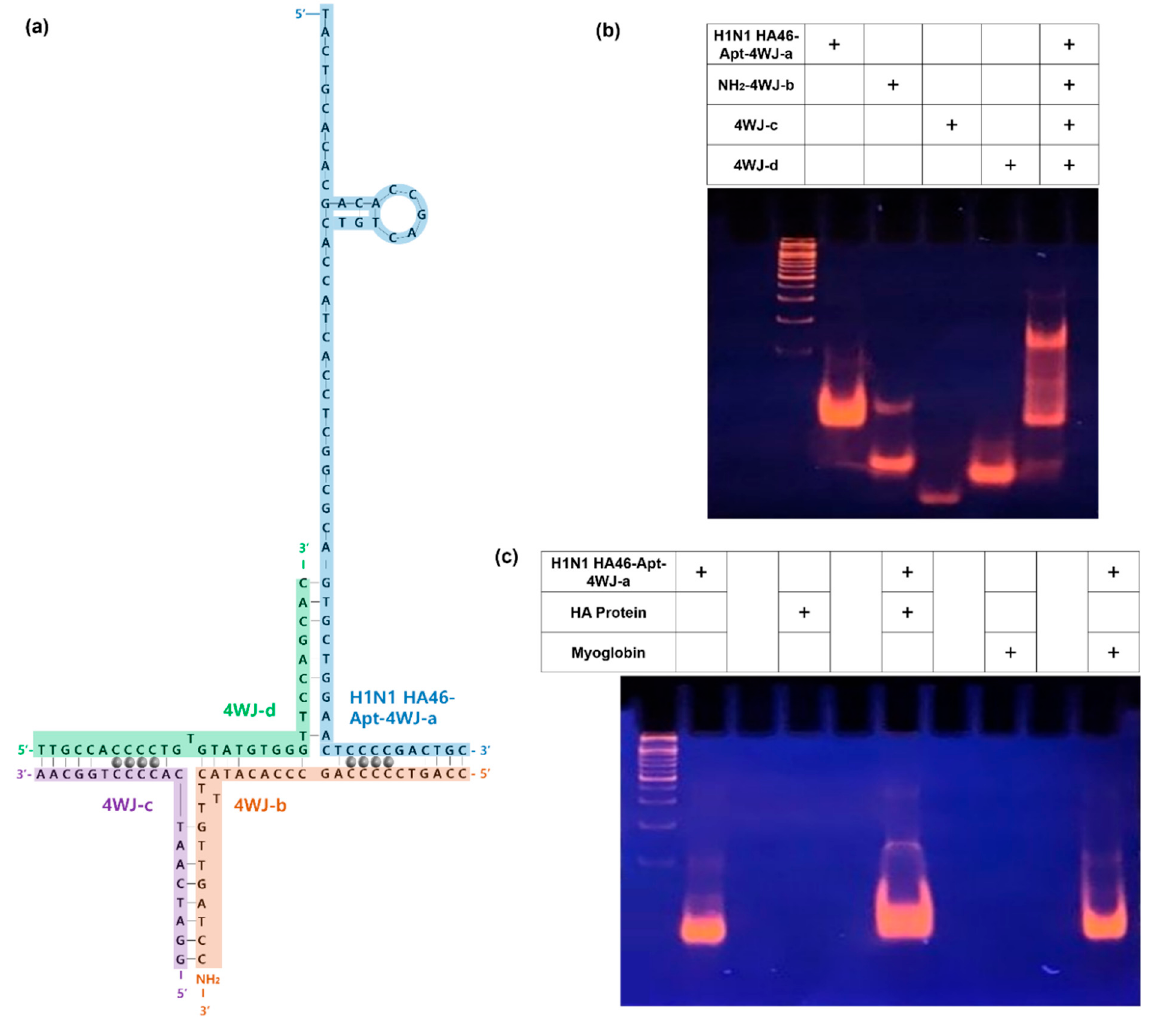
Figure 2. ( a ) Schematic image of expected multifunctional DNA 4WJ structure from 4WJ-a of H1N1 aptamer for detection (blue line), amine-modified 4WJ-b for immobilization (orange line), 4WJ-c for immobilization (purple line), 4WJ-d for immobilization (green line), and intercalated silver ions (silver circles). ( b ) TBM-PAGE gel image 4WJ structure. ( c ) TBE- PAGE gel image of 4WJ-a, HA protein, myoglobin. 4WJ, four-way junction; PAGE, polyacrylamide gel electrophoresis.